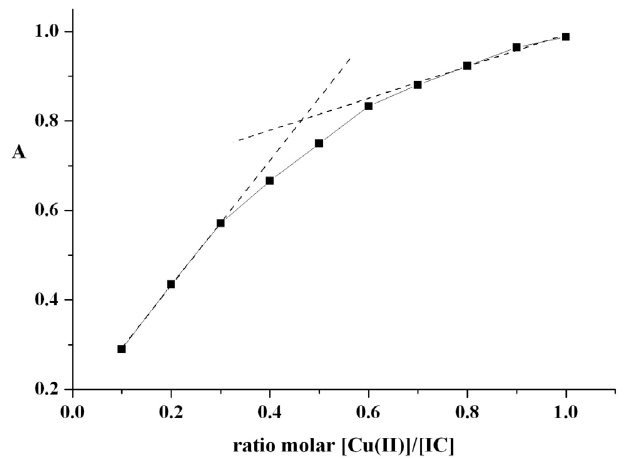
FIGURE 5 - Plots of absorbance of complex versus molar ratio of components: 1x10 -4 mol L -1 indigo carmine and 1x10 -6 to 1x10 -4 mol L -1 Cu(II) solutions.